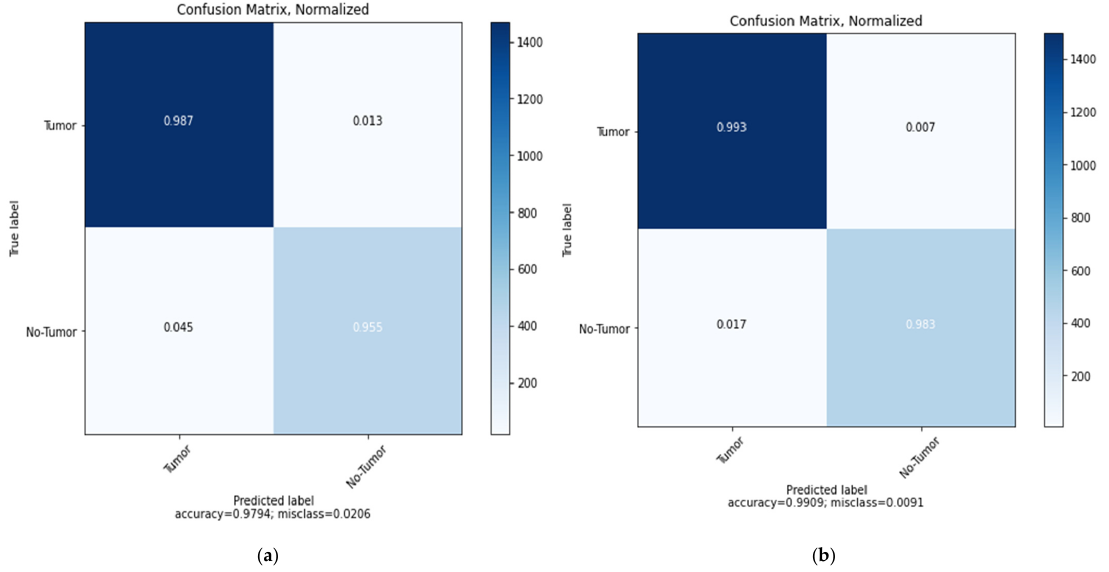
Figure 12. Confusion matrix for the proposed ResNet152V2 model: ( a ) using Vanilla GAN image generated; ( b ) using DCGAN image generated.